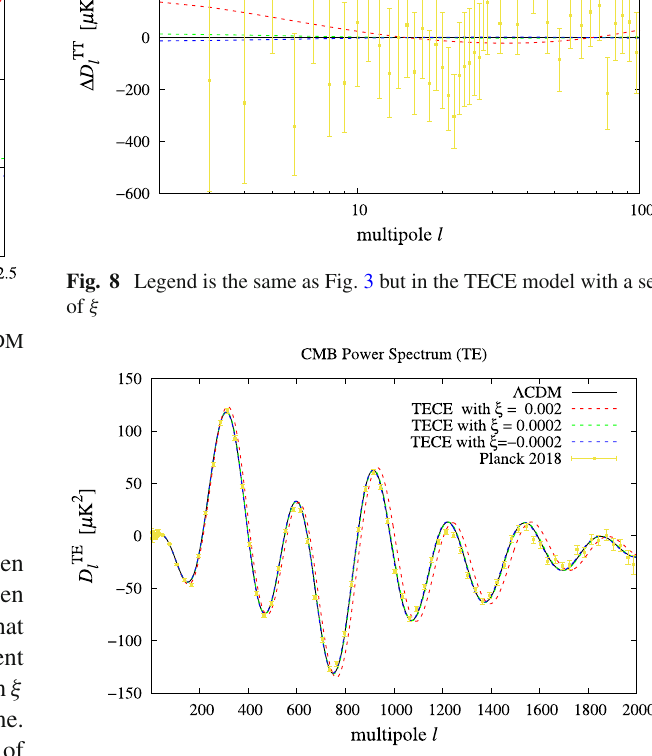
Fig. 9 Legend is the same as Fig. 4 but in the TECE model with a set of